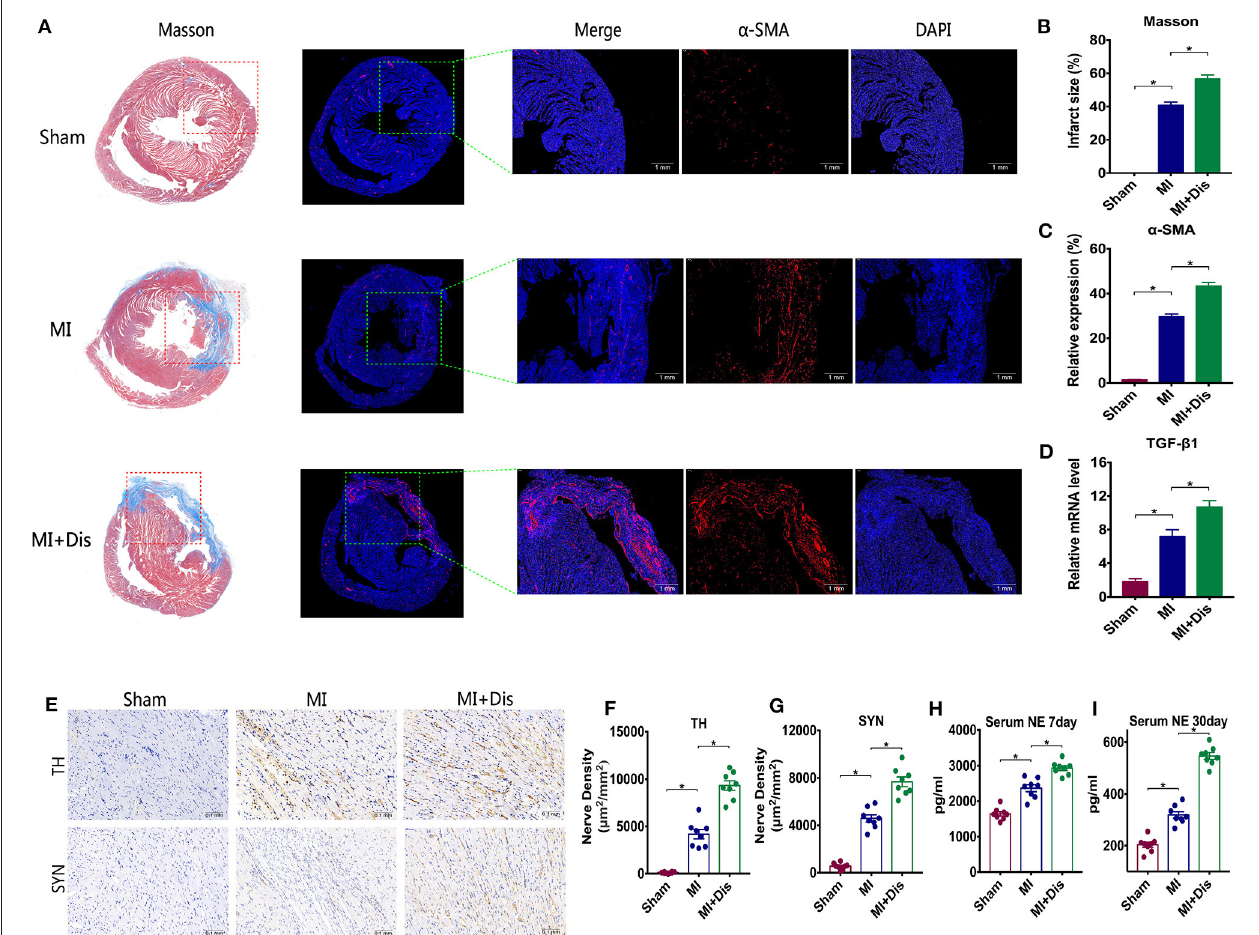
FIGURE 2 | Cardiac fibrosis and sympathetic remodeling were aggravated by circadian disruption after MI. Representative images of staining for Masson (blue) and α -SMA (red) in all groups are shown in (A) , and quantitative analysis is shown in (B,C) . Real-time PCR results of TGF- β 1 are shown in (D) . TH and SYN staining are used to assess sympathetic nerve sprouting and synaptic density in the heart (E–G) . (H,I) Serum NE levels. α -SMA, alpha smooth muscle actin; TGF- β 1, transforming growth factor beta 1; NE, norepinephrine; TH, tyrosine hydroxylase; SYN, synaptophysin; p * <